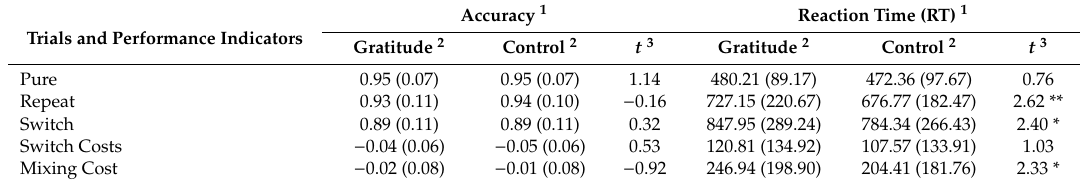
Table 2. Reaction times, accuracy rates, and task-switching costs in magnitude–parity switching task. Accuracy Trials and Performance Indicators